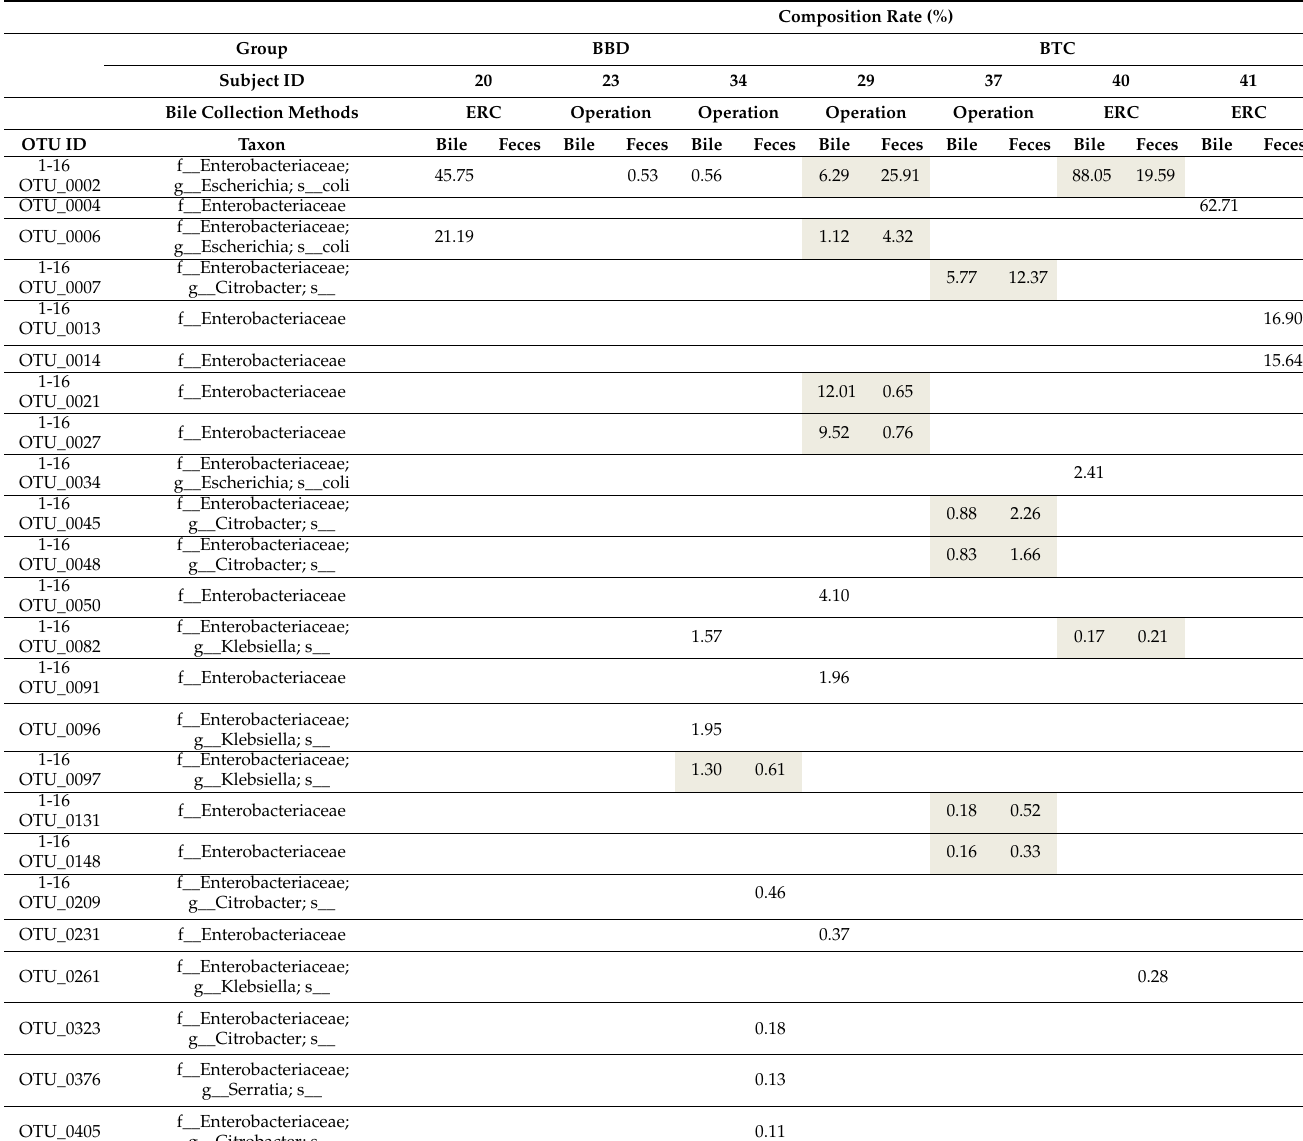
Table 2. OTUs assigned to Enterobacteriaceae in bile and fecal